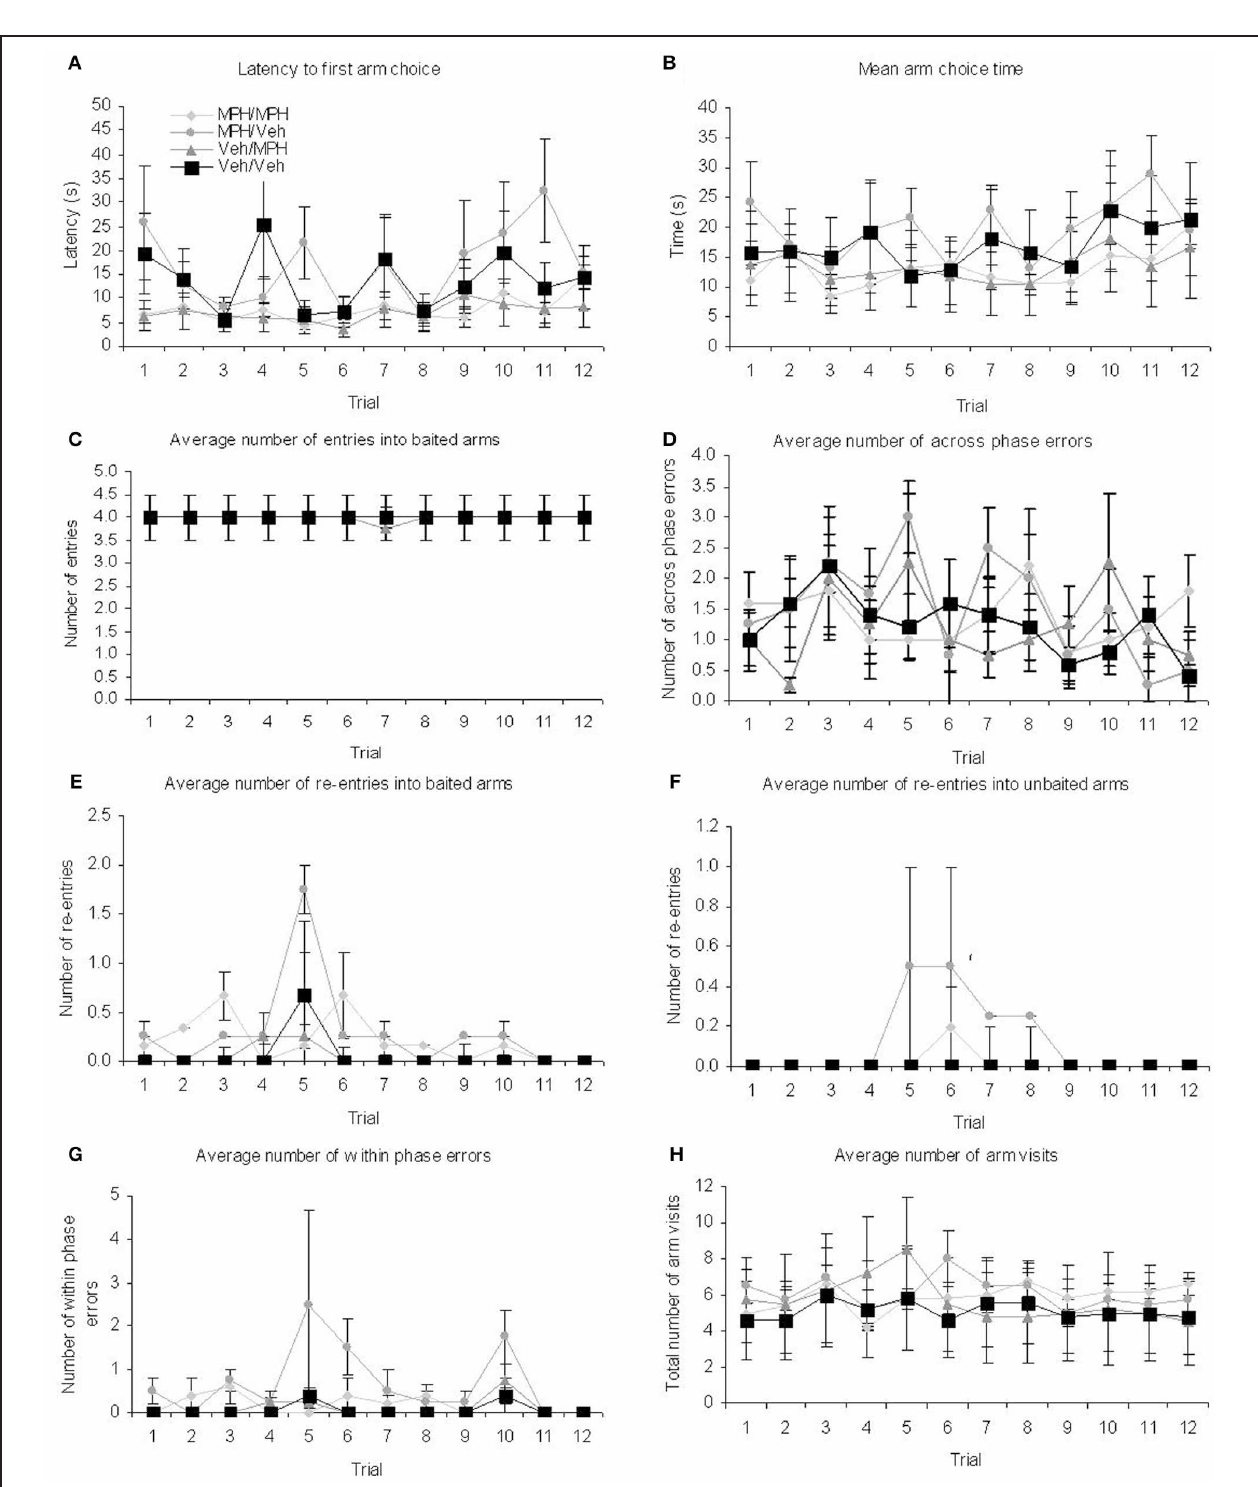
FIGURE 5 | Performance during the test phase on the 3h DWST over the 12 trials run at this delay revealed that there were some pre-existing group differences for the treatment groups selected for the 6h delay. (A) latency (B) mean arm choice time (C) baited arm entry (D) across phase errors data did not show pre-existing differences. By contrast (E) baited arm re-entry (F) unbaited arm re-entry (G) within phase errors and (H) total number of arm visits data did show pre-existing differences. Prior to any drug